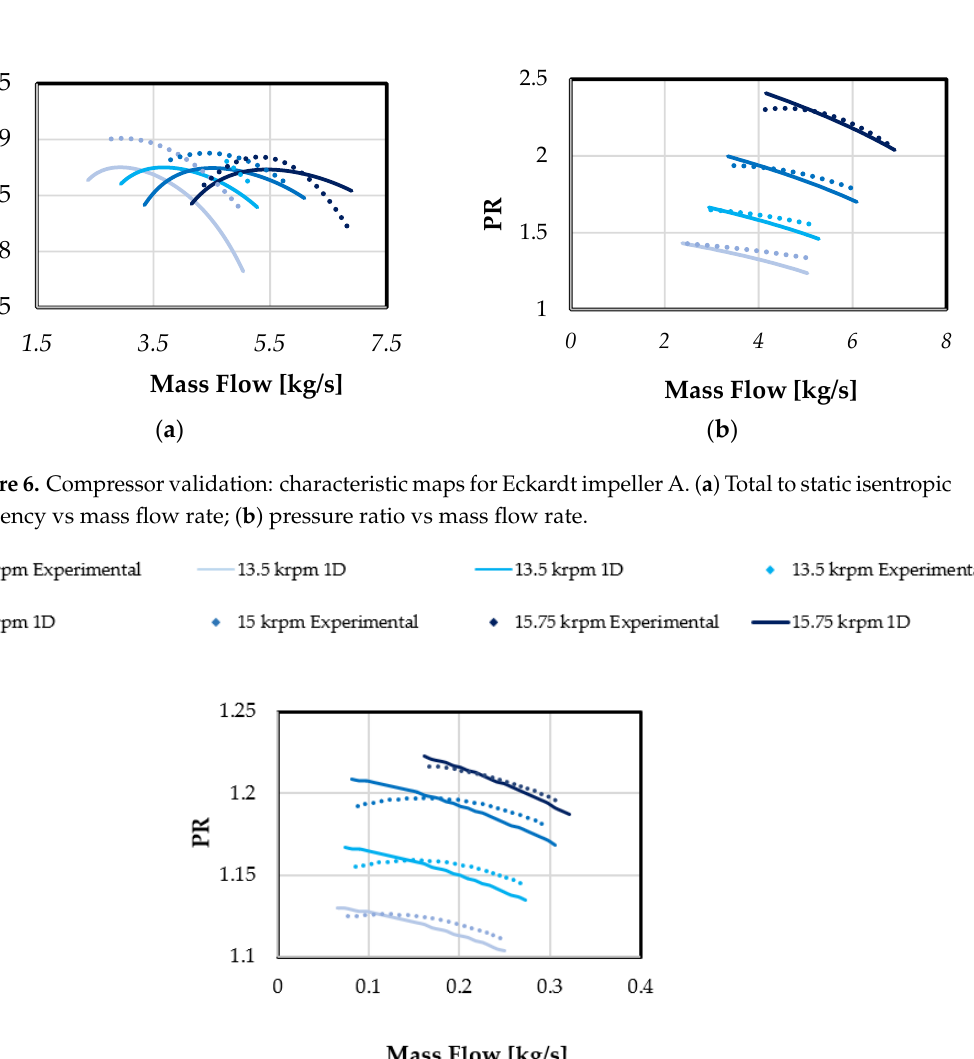
Figure 7. Compressor validation: characteristic maps for KIMM impeller.